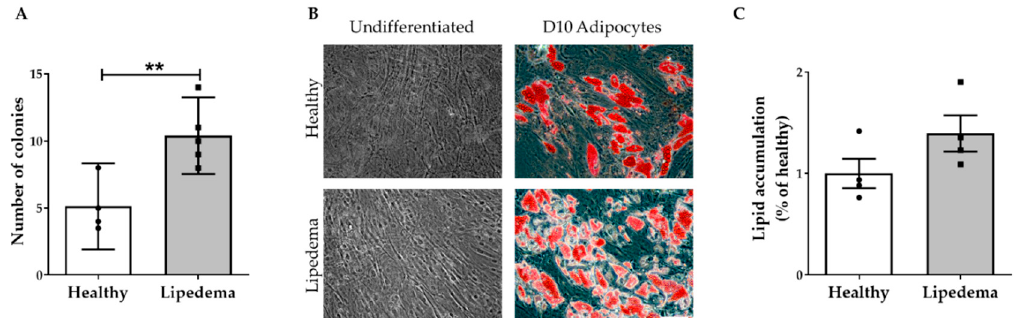
Figure 6. Characterization of ASC derived from 3D spheroids. ( A ) Quantitative analysis of the colony-forming unit fibroblast (CFU-F) assay revealed a significant increase in the CFU potential of ASCs from lipedema patients compared with healthy individuals (healthy n = 4; lipedema n = 5). The results are displayed as scatter plots with bars. The values are the mean ± SEM. ** p < 0.01. ( B ) Representative photomicrographs of the adipogenic differentiation of ASCs determined by Oil Red O staining 14 days after the induction adipogenesis. Lipid droplets (red) observed inside differentiated cells (scale bar, 100 µm). ( C ) The quantitative analysis of Oil Red O stain by spectrophotometric analysis showing a trend of an increase in the adipogenic differentiation potential of lipedema ASCs compared to healthy ASCs ( n = 4 per group). The results are displayed as scatter plots with bars. The values are the mean ± SEM.